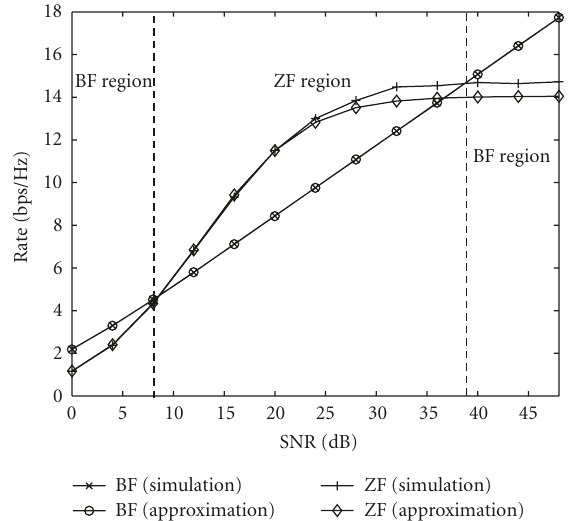
Figure 3: Mode switching between BF and ZF modes with both CSI delay and channel quantization, B = 18 bits, N t = 4, f c = 2 GHz, T s = 1msec, v =